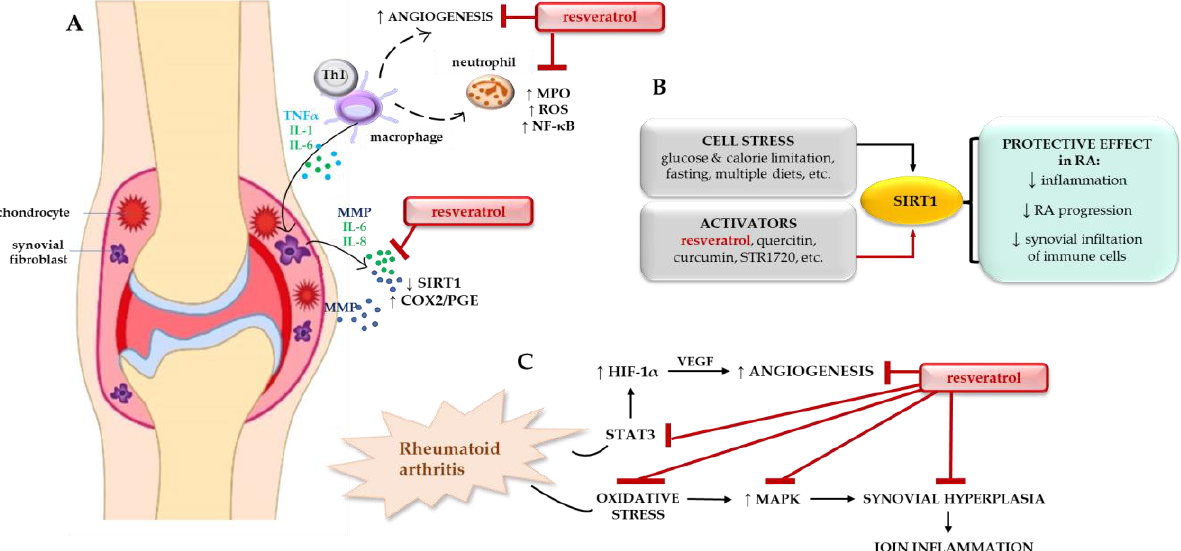
Figure 3. Prevention role of resveratrol in rheumatoid arthritis. ( A ) The pathophysiological mechanism of rheumatoid arthritis (RA) controlled by environmental factors, gene interactions, and the immune cells response, ( B ) SIRT1 activating factors and its protective effects in RA, ( C ) Resveratrol’s role in counteracting RA development. Abbreviations: COX2, cyclooxygenase 2; IL, interleukin; TNF α , tumor necrosis factor alfa; MMP, metalloproteinases; MPO, myeloperoxidase; NF- κ B, nuclear factor kappa B; PGE prostaglandin E; ROS, reactive oxygen species; VEGF, vascular endothelial growth factor; SIRT1, sirtuin 1; MAPK, mitogen-activated protein kinases; HIF-1 α , hypoxia-inducible factor 1-alpha; STAT3, signal transducer and activator of transcription 3; Th1, T helper cells.